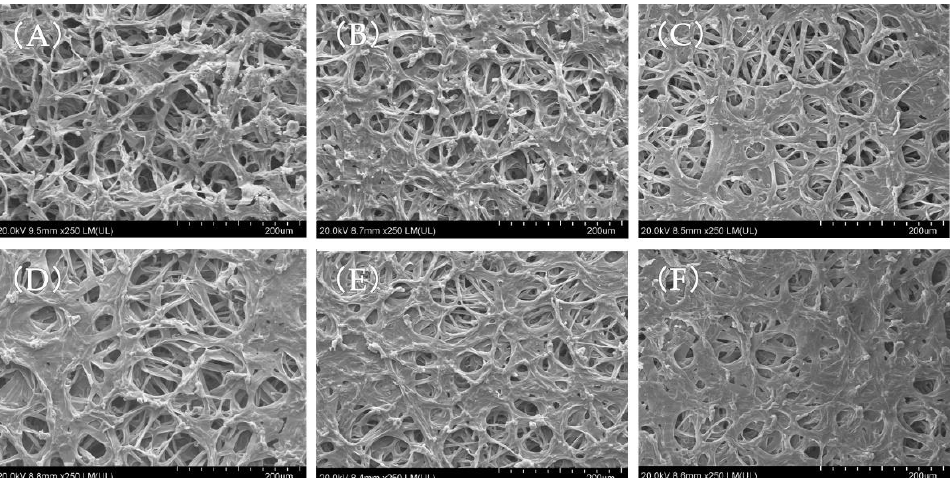
Figure 8. Surface microstructure of shiitake mushroom slices treated by different voltages. ( A ) Control; ( B ) 18 kV; ( C ) 22 kV; ( D ) 26 kV; ( E ) 30 kV; ( F ) 34 kV.